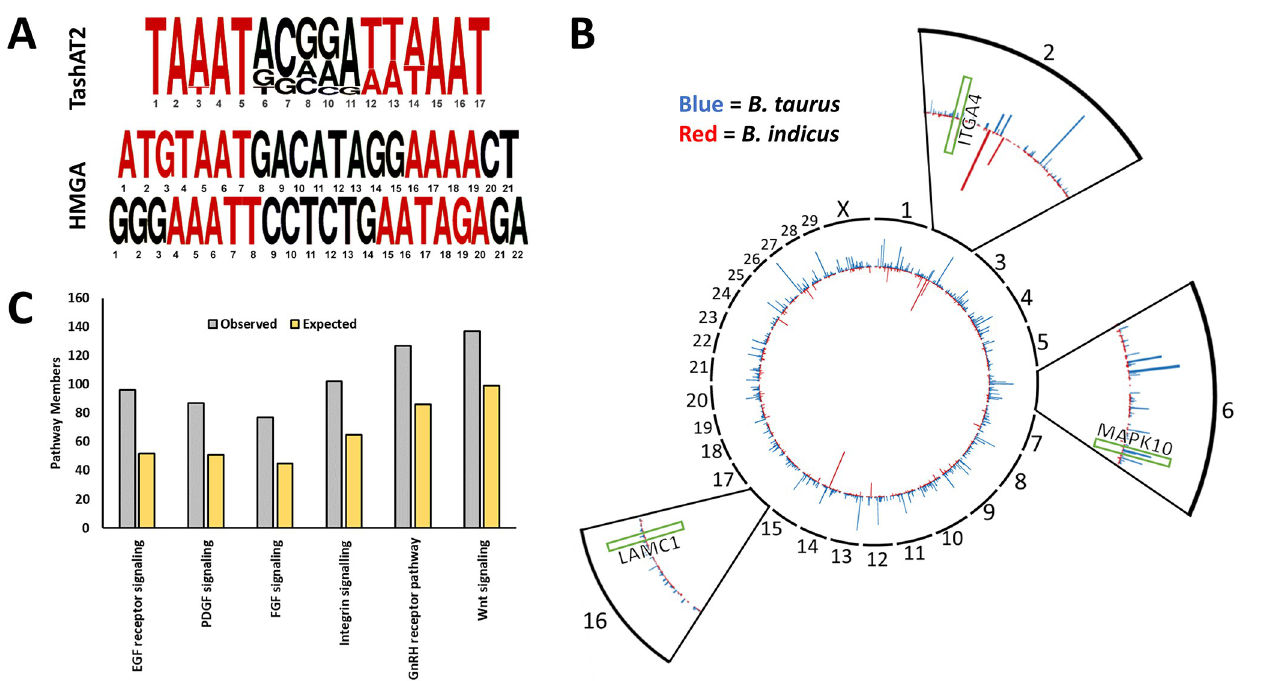
Fig 7. Analysis of DNA motifs bound by the parasite encoded TashAT2 factor in the genomes of B . indicus vs . B . taurus . (A) Consensus motif of the DNA region bound by parasite TashAT2 in the genome of B . indicus vs . B . taurus compared to the binding motifs of mammalian HGMA [19]. AT rich regions bound by AT hooks found in both TashAT2 and HGMA are shown in red. (B) A CIRCOS summary plot with automatic binning showing the number of TashAT2 binding motifs found in genes across the B . indicus (red) and B . taurus (blue) genomes. Genes with the same number of motifs are excluded to demonstrate the pattern of differences between each breed. Zoomed views are shown for chromosomes 2, 8 and 16 without automatic binning. The approximate regions of genes in the “EGF” and “Integrin signalling” pathways that possess different numbers of TashAT2 binding motifs and differ in expression between infected Holstein and Sahiwal breeds are indicated in green ( ITGA4 , MAPK10 and LAMC1 ). (C) Overrepresented PANTHER pathways in the cohort of bovine genes with FDR adjusted p value < 0.05 after a Fisher’s Exact test. Blue is the observed members of a pathway in the dataset, whereas red indicates the expected number if the distribution was